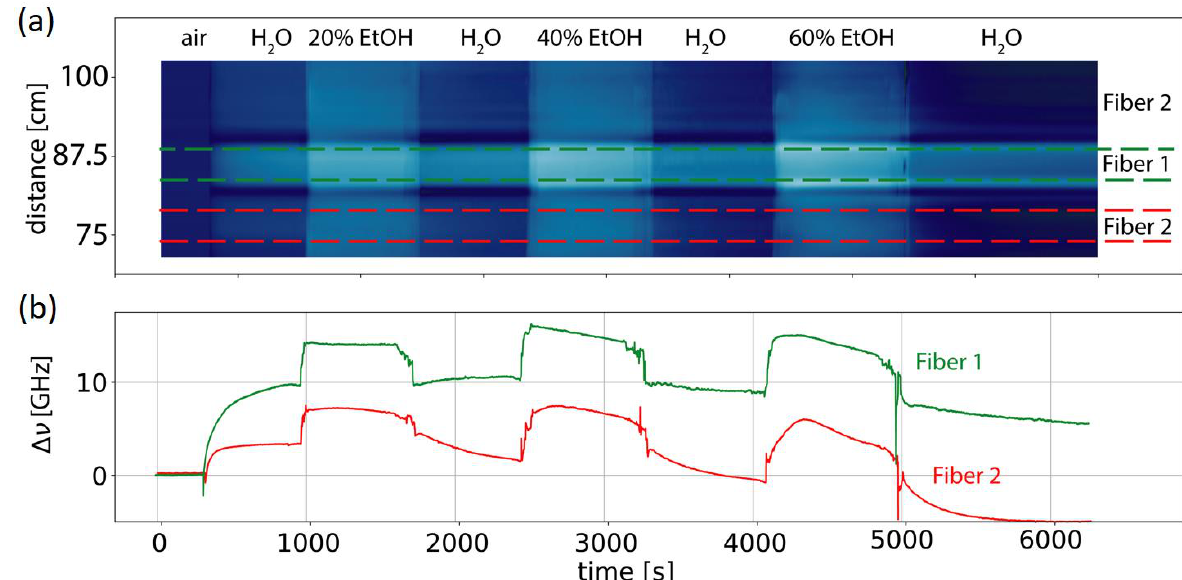
Figure 3. ( a ): Colormap of the observed optical frequency shift (∆ν) against distance and time. ( b ): Rayleigh frequency shifts averaged over the different fiber segments as indicated in the top graph. Each distance increment corresponds to 1.25 mm.